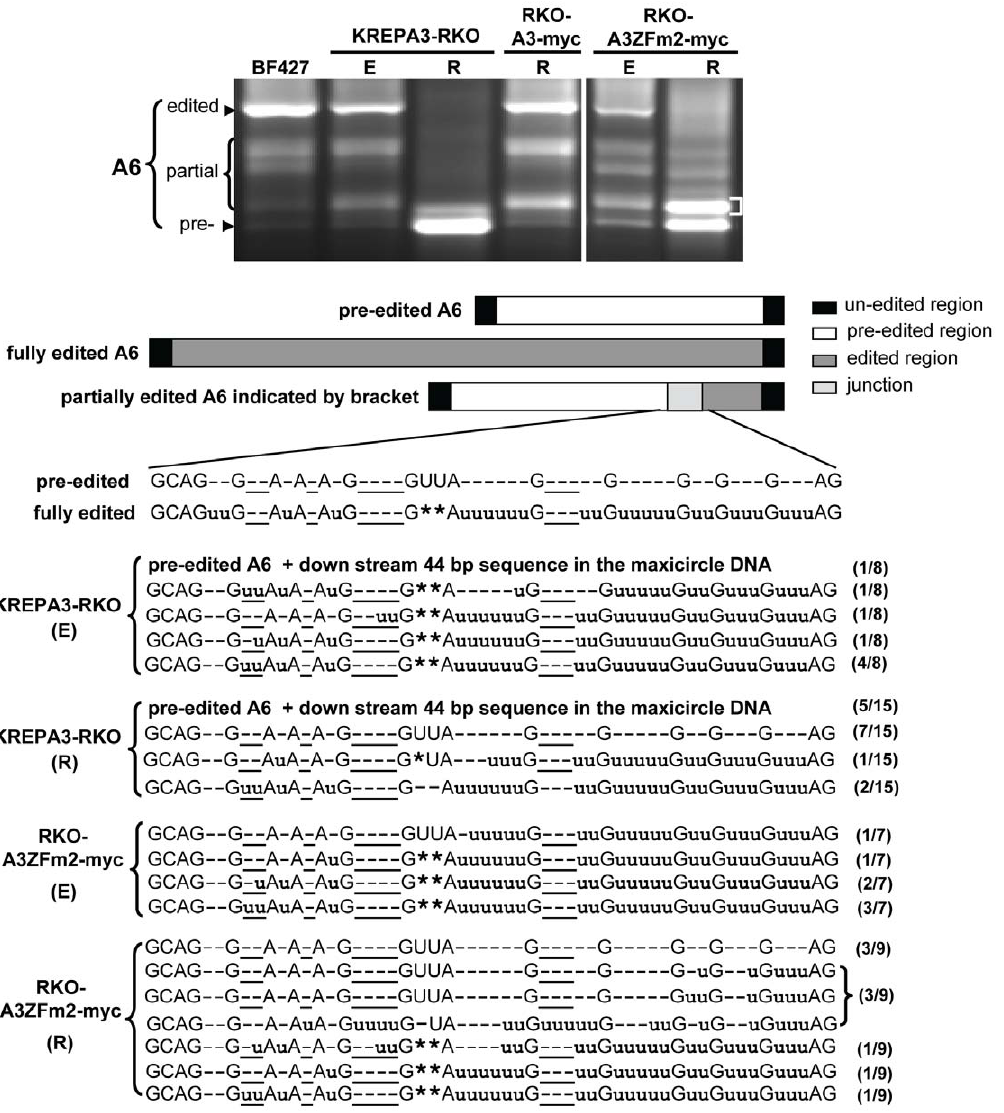
Figure 3. Sequences of gel isolated RT-PCR products of the partially edited A6 mRNAs. A6 mRNA RT-PCR products from KREPA3-RKO and RKO-A3ZFm2-myc cell with KREPA3 Reg expressed (E) or repressed for three days (R), respectively, were isolated from agarose gels. BF 427 RNA was used as a control. The region of the gel from which the DNA was cut, cloned and sequenced is indicated with the bracket. The relative location of the partially edited sequence in the junction between the unedited and edited sequences is shown schematically. Inserted u’s are shown in lower case, each deleted U is shown as an asterisk (*), and those not matching fully edited RNA are underlined. The number of the clones found with each shown sequence is indicated in parentheses on the right. In some cases (indicated by text instead of sequence), pre-edited A6 sequences were obtained due to mis-priming at a site downstream of the A6 coding sequence, thereby creating PCR products large enough to be found in the excised band.